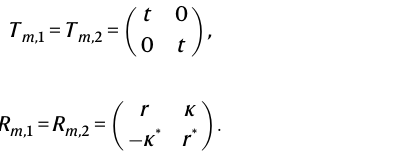
correspond to transversal modes that excite the same mode-